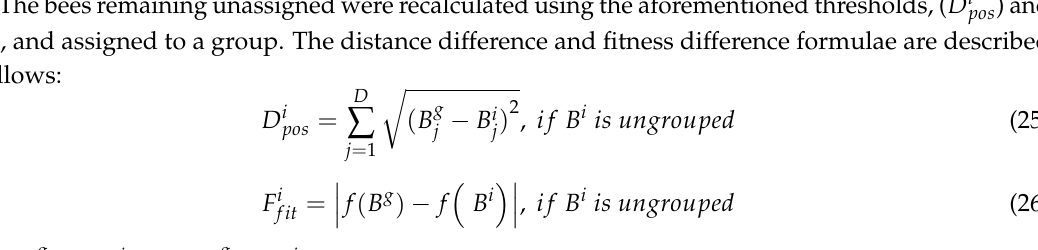
Figure 13. Similar bees assigned to same group.